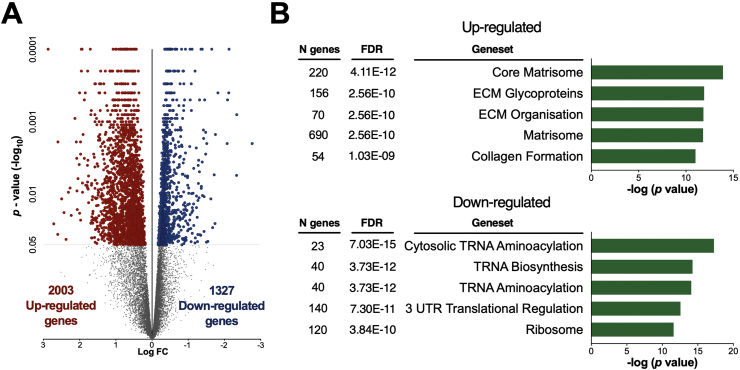
VDR-OE upregulates hypertrophy and extracellular remodelling related gene-sets. (A) Volcano plot of p < 0.05 statistically significant up-/downregulated genes. (B) Top five upregulated and downregulated gene-sets from the molecular signatures database in VDR-OE muscles (n = 7). See also Supplemental File 1.